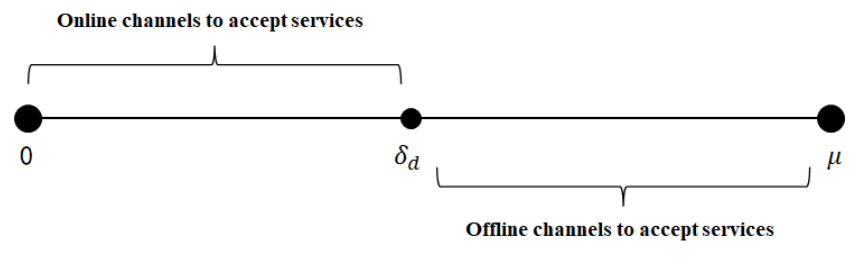
Figure 2. Patient channel selection under dual-channel strategy according to µ